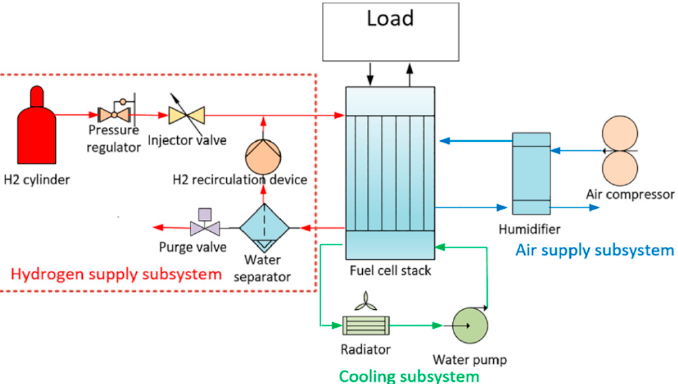
Figure 12. Schematic diagram of a PEMFC system for fuel cell vehicle (reproduced with permission from Reference [142]; copyright © 2022 The Authors. Published by Elsevier Ltd.).